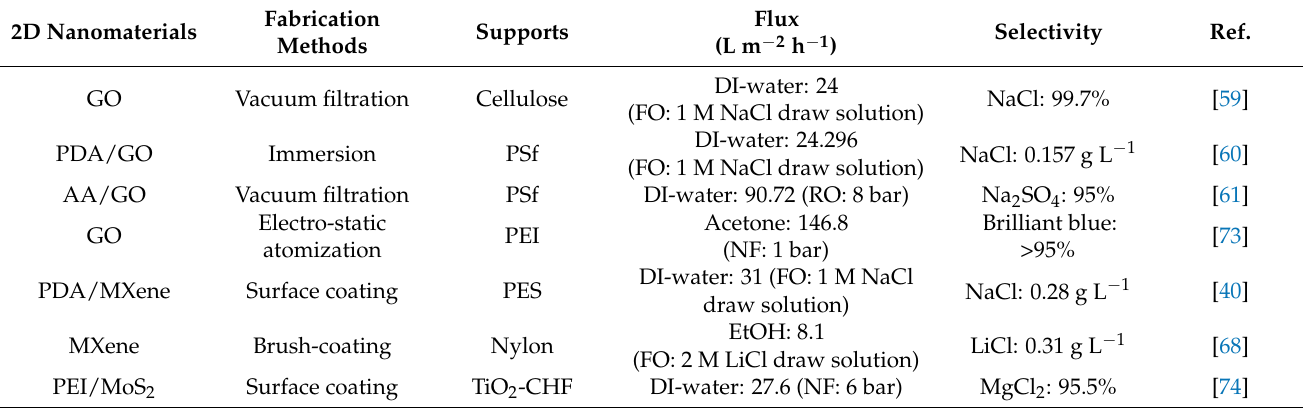
Table 1. Performances of TFNi membranes with representative 2D nanomaterials